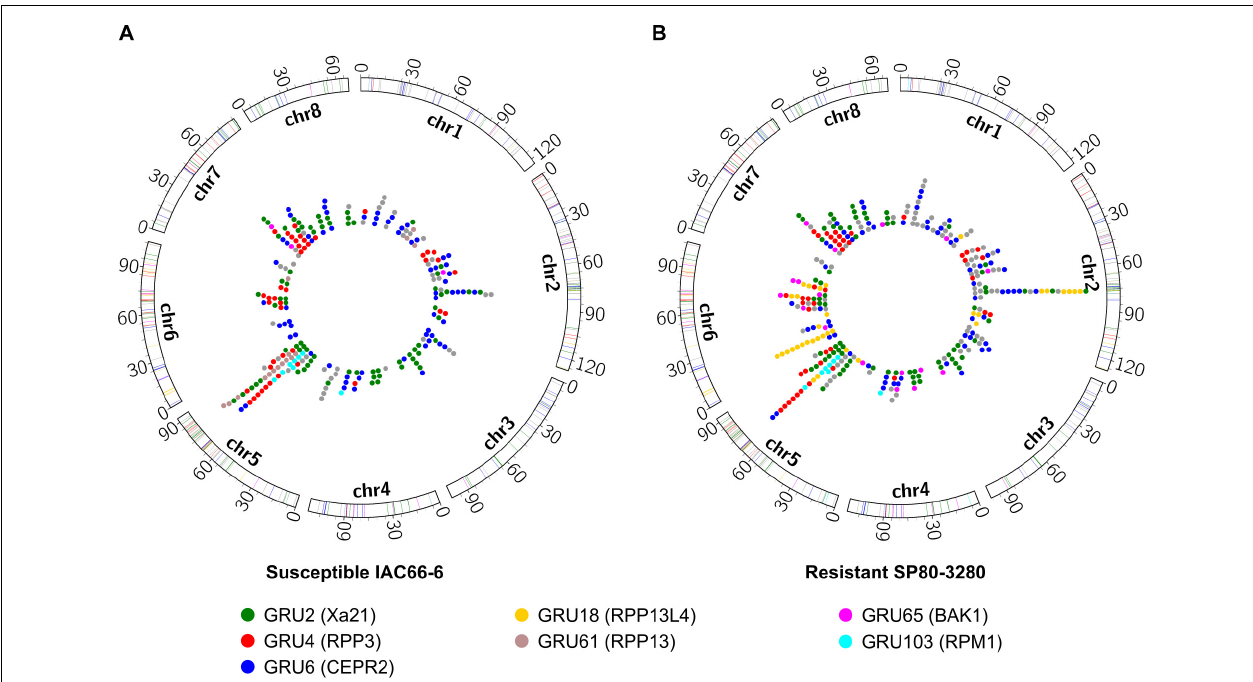
FIGURE 4 | Distribution of Saccharum spontaneum orthologs of RGAs identified as within core-periphery subnetworks and DE in each of the two sugarcane transcriptome experiments of (A) susceptible IAC66-6 genotype and (B) resistant SP08-3280 genotype. Colored dots within circles indicate the positions of RGA orthologs along eight chromosomes, as well as the colored traces in chromosome bars. Colors depict seven main orthogroups according to the legend, and gray color depicts orthologs from other orthogroups.